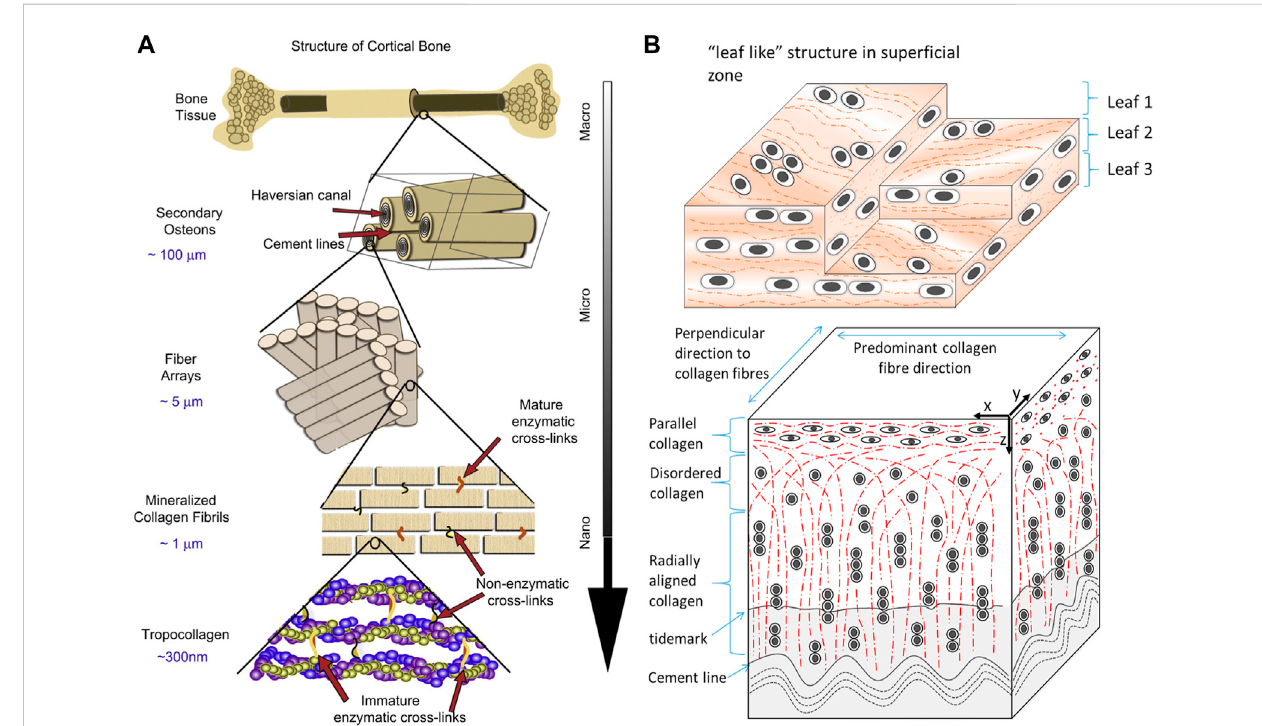
FIGURE 2 Schematic diagrams of the hierarchical structure of (A) human cortical bone and (B) cartilage. Adapted with permission from ref (Barth et al., 2011; Mans fi eld et al., 2015). Copyright 2011 Elsevier, 2015